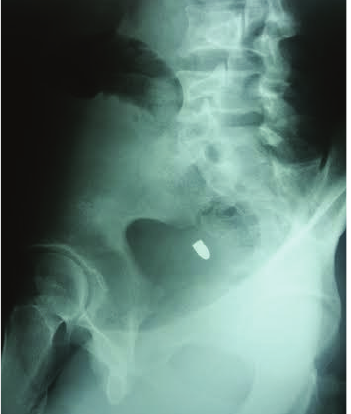
Figure 2: Lateral abdominal radiograph shows the bullet in the pelvic cavity.